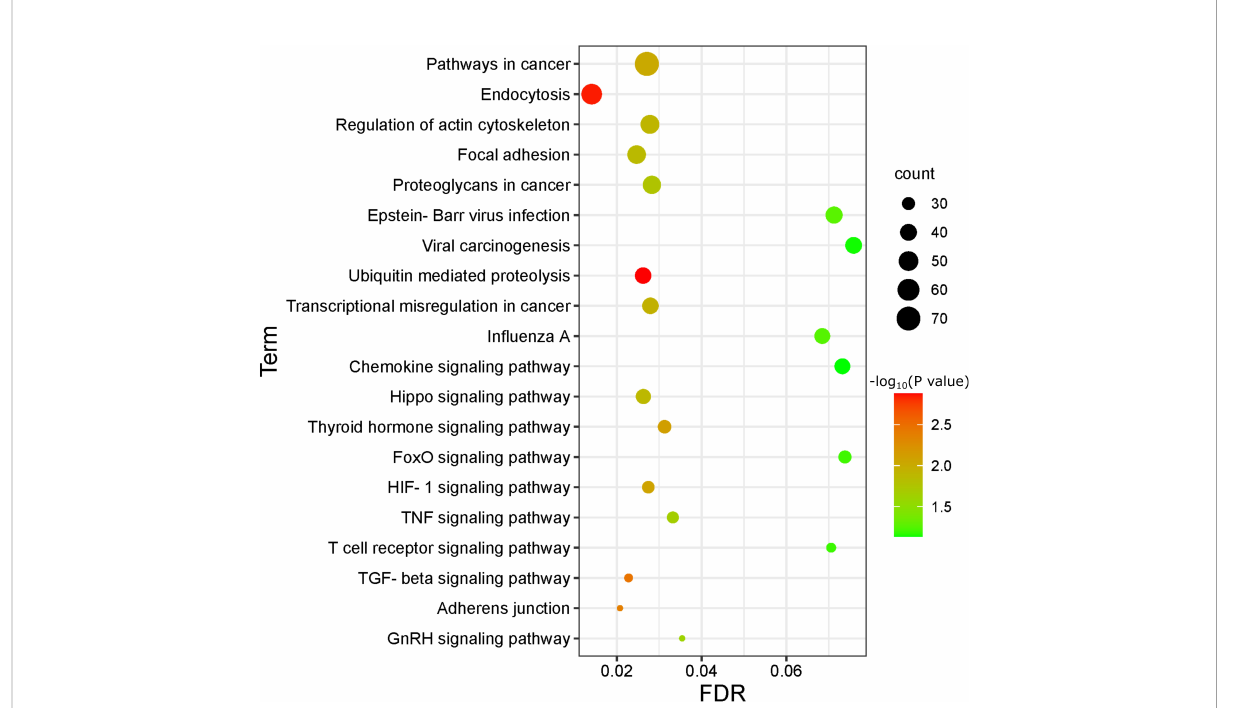
FIGURE 3 Bubble Plot of KEGG enrichment analysis on predicted target genes of DE lncRNAs comparing ETEC-infected IPEC-J2 cells versus wild-type. The enriched pathways are displayed on the y-axis, and the x-axis represents the false discovery rate (FDR) which means the probability of false positives in all tests. The size and color of dots represent the number of enriched genes and corresponding P-value,